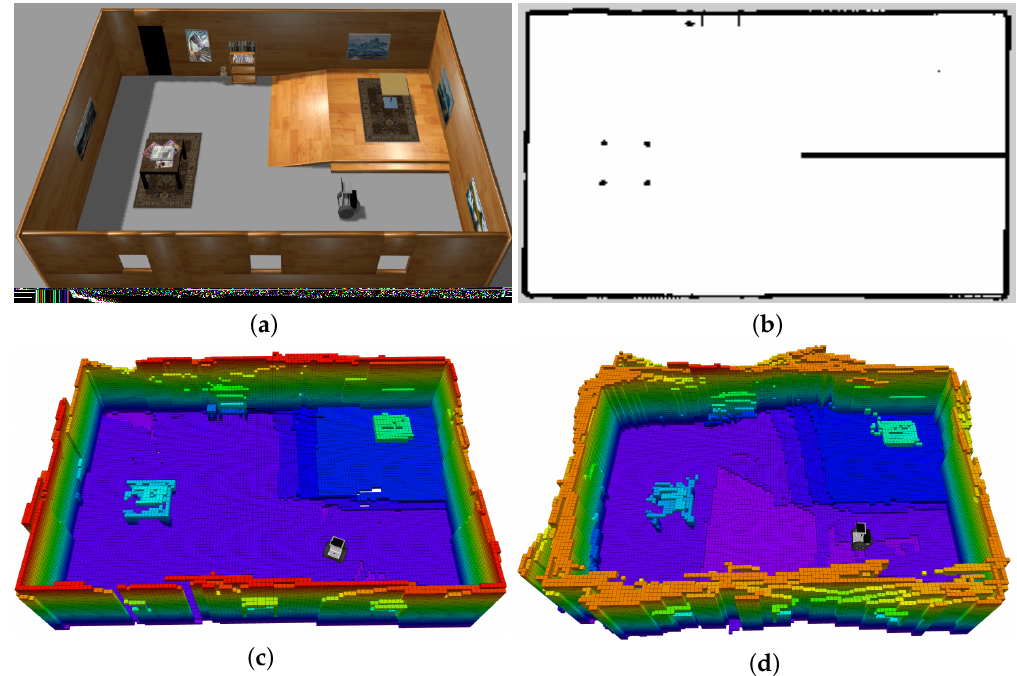
Figure 7. Traversable map generated from the pre-build OctoMap. ( a ) simulation environment; ( b ) traversable map; ( c , d ) OctoMap built by the 2D+3D SLAM method and singly 3D SLAM method.